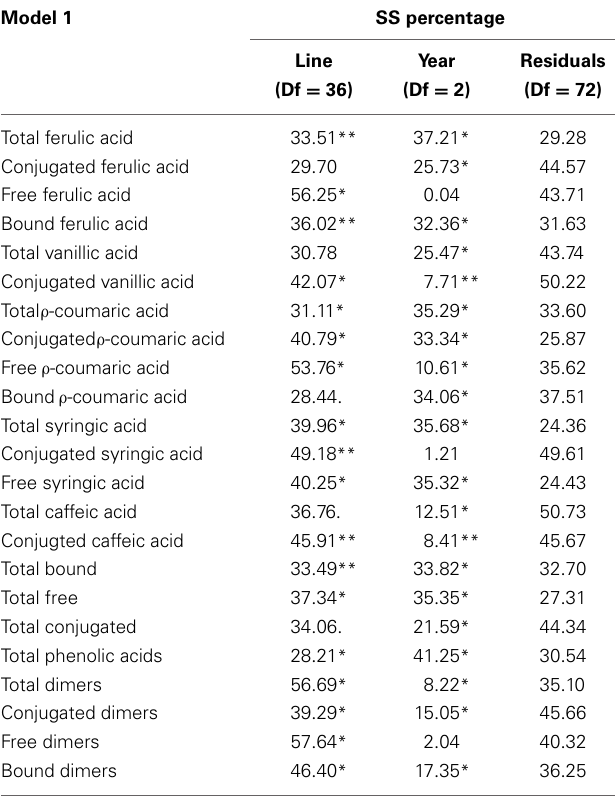
Table 3 | Table with the percentage of variance explained by each factors, derived from the ANOVA table of Model 1 (‘variable ∼ Line +